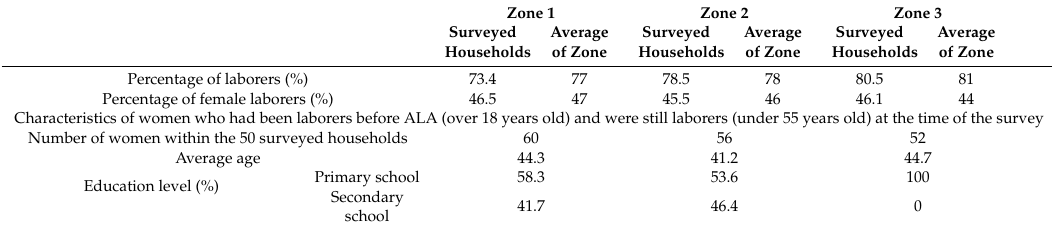
Table 1. Characteristics of surveyed households and women at the study